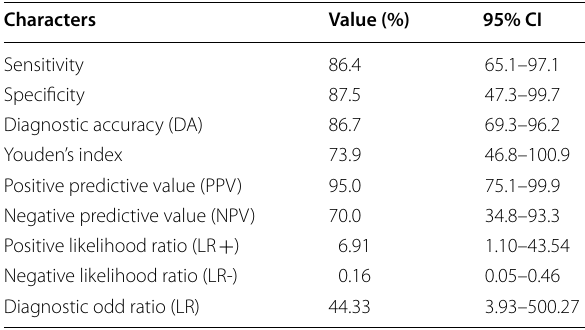
Table 7 Diagnostic characteristics of MRI DWI/ADC findings